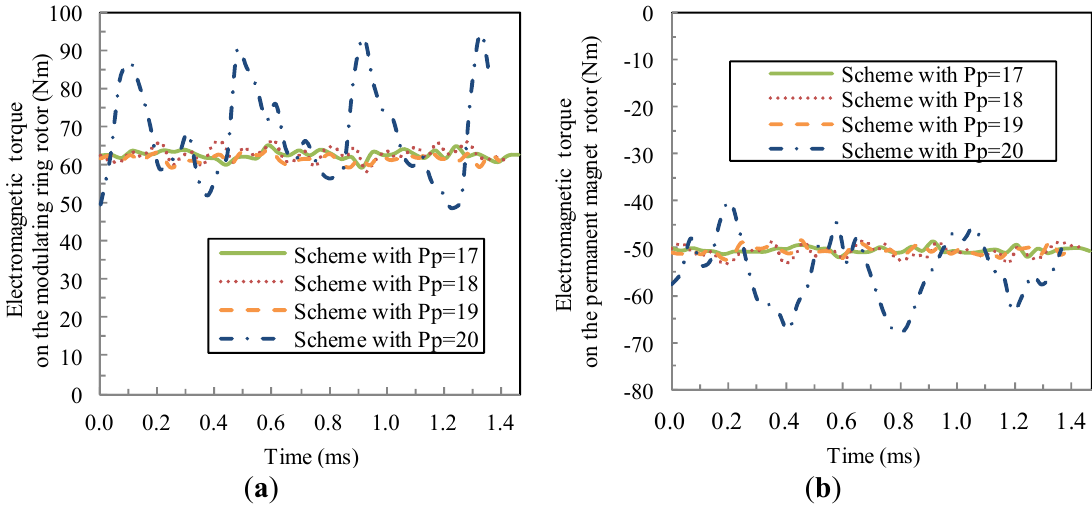
Figure 17. Electromagnetic torque waveforms: ( a ) electromagnetic torque on the modulating ring rotor; and ( b ) electromagnetic torque on the permanent magnet